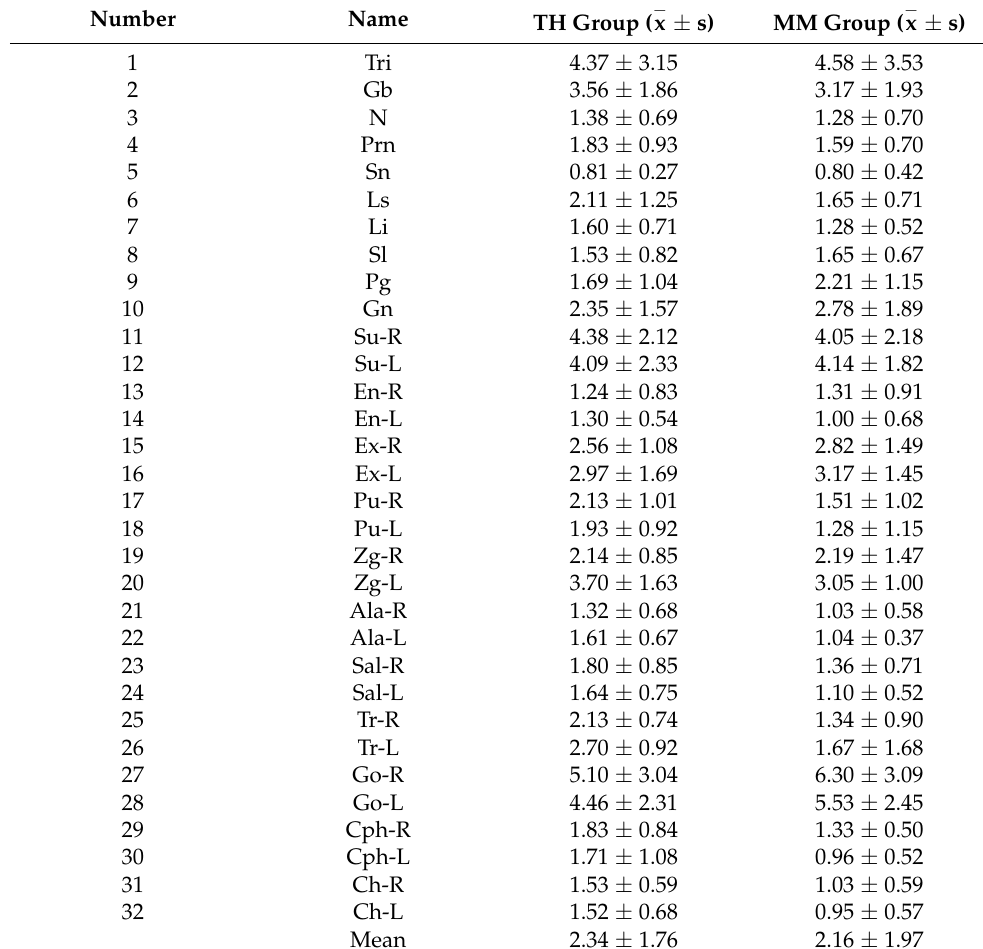
Table 2. Landmark localization errors for the 3D facial anatomical landmarks